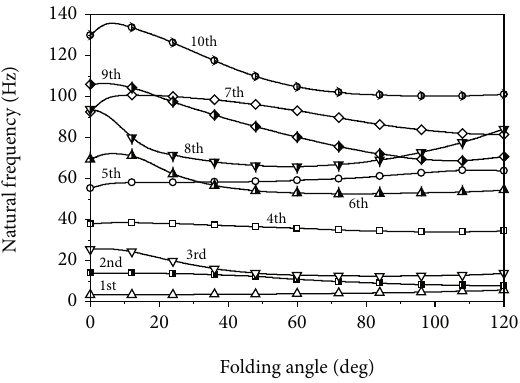
Figure 6: Variations of the fi rst ten natural frequencies with the folding